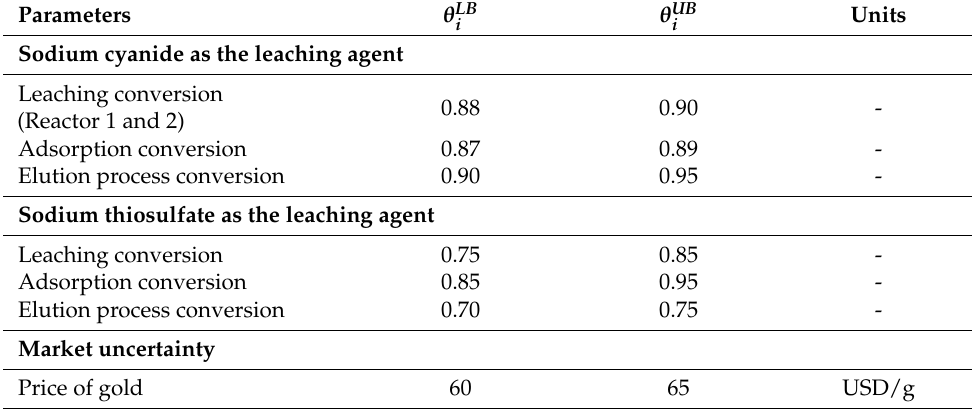
Table 5. Lower and upper bounds of parameters including uncertainty.